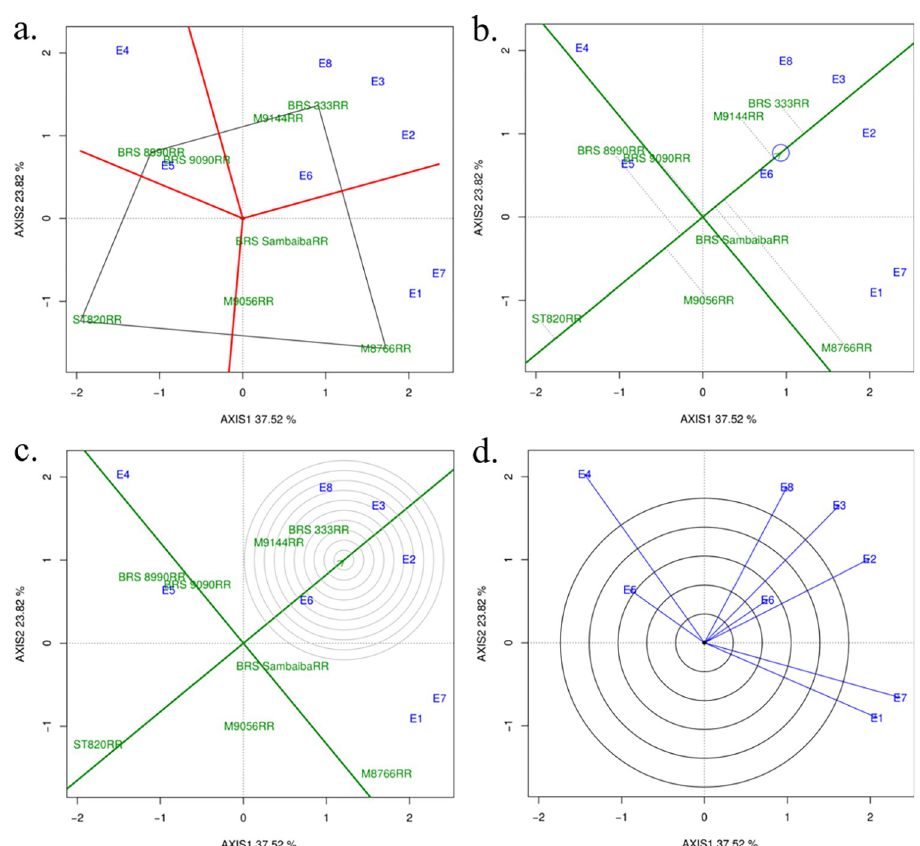
Fig 1. (a) GGE biplot representing the which-won-where, where the genotypes at the vertices of the polygon represent the genotypes indicated for the respective mega-environments formed (red lines). (b) GGE-biplot analysis for “mean performance versus stability” for yield of soybean genotypes. (c) GGE biplot comparing eight genotypes evaluated according to the estimate of an ideal genotype. (d) GGE biplot comparing eight soybean genotypes evaluated according to the discrimination and representativeness of environments for grain yield (kg ha -1